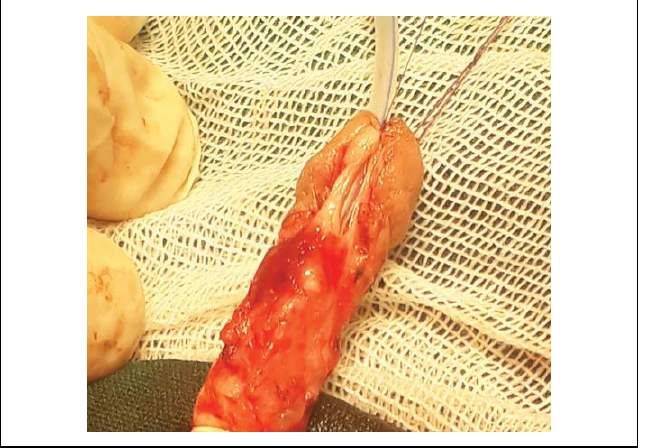
Figure 2. Urethral plate tubularization in circumcised MIP.